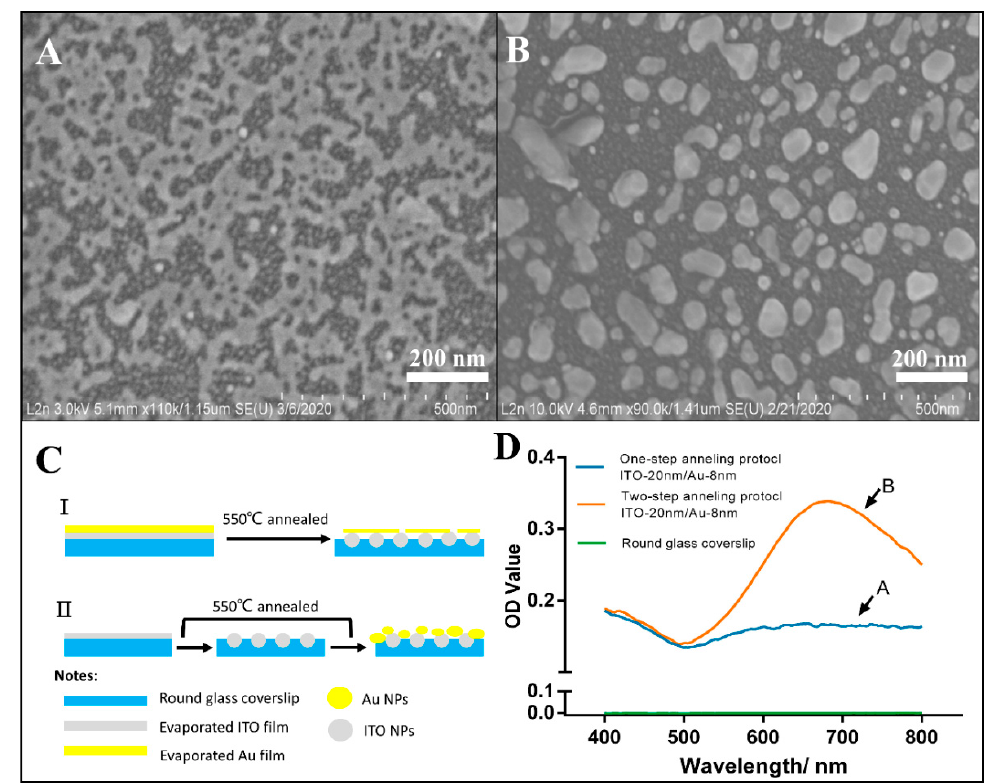
Figure 3. SEM image of ( A ) one-step and ( B ) two-step annealed ITO-20 nm/Au-8 nm NPs; Nanostructuration of coverslips with ITO-20 nm/Au-8 nm NPs ( C ) and the localized surface plasmon resonance (LSPR) characterization of one-step and two-step annealed ITO-20 nm/Au-8 nm NPs samples ( D ).